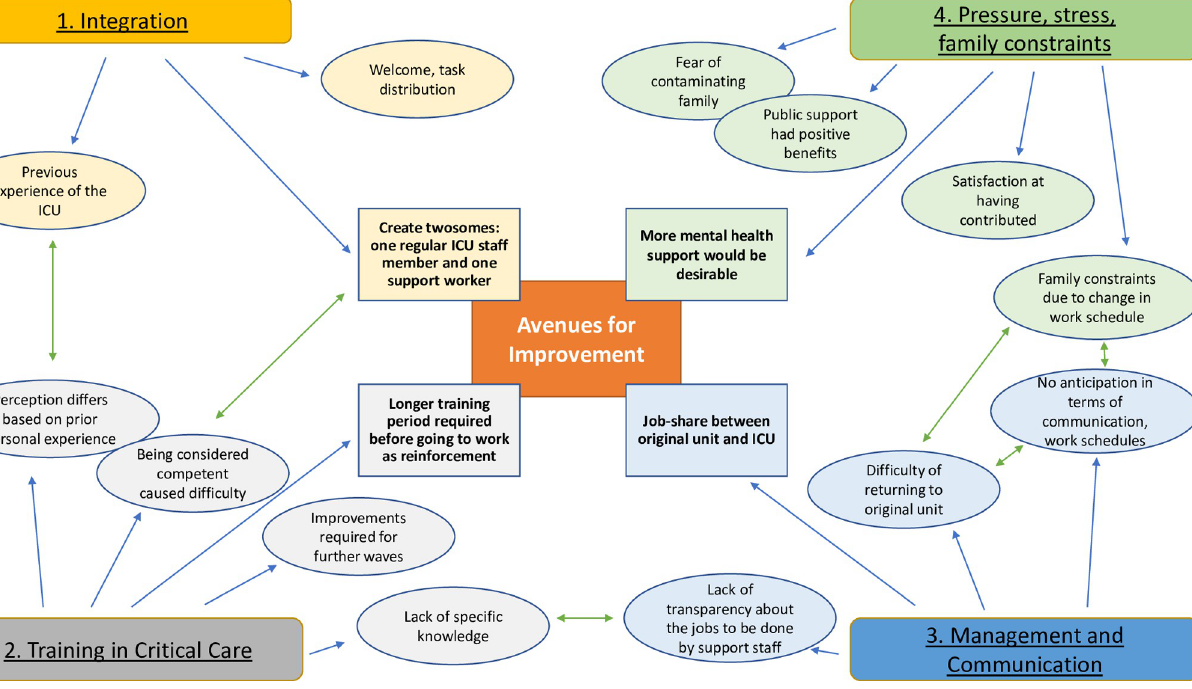
Fig 1. Conceptual framework summarizing the main